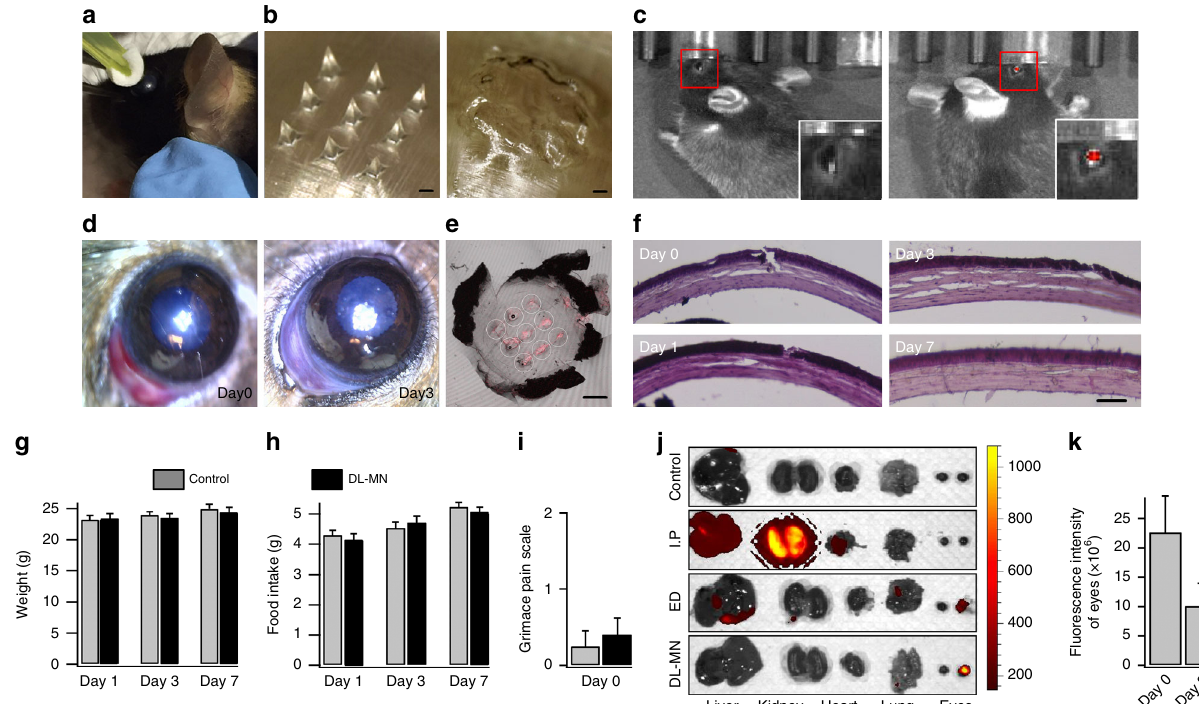
Fig. 6 In vivo studies of self-implantable double-layered microneedles. a A polymeric patch containing 3 × 3 DL-MNs was applied on the central region of mouse eye (~30 s). b Bright- fi eld images of the patch, before (left) and after (right) insertion into the eye, are shown. Scale bars = 200 µ m. c In vivo imaging of the eyes, applied without (left) or with IgG(680)-loaded MN patch (right). d , e Bright fi eld images of the eye treated with a IgG(680)-loaded MN patch, at day 0 (immediately after insertion) and at day 3 ( d ). The red fl uorescence spots in the cornea mark the penetration sites ( e ). Scale bar = 500 µ m. f The representative histological changes of mouse cornea, at day 0, day 1, day 3 or day 7 after MN patch application. Scale bar = 100 µ m. g – i The weight ( g ), food intake ( h ), and the grimace scale for pain assessment ( i ) were examined at day 0 (2 h after insertion), day 1, day 3 or day 7 after patch application. Data represent mean ± SEM ( n = 5). j , k In vivo distribution of IgG in mice, treated without (control) or with systemic injection (intraperitoneal, I.P.), eye drop (ED) (one-side only) or MN patch application (one side only) of IgG(680). The representative fl uorescence images of dissected organs, 2 h after treatment, are shown in ( j ). The quantitative analysis (mean ± SEM; n = 5) of fl uorescent intensities of eyes treated with MN patch at day 0 and day 3 is shown in ( k ). n represents the number of samples for each